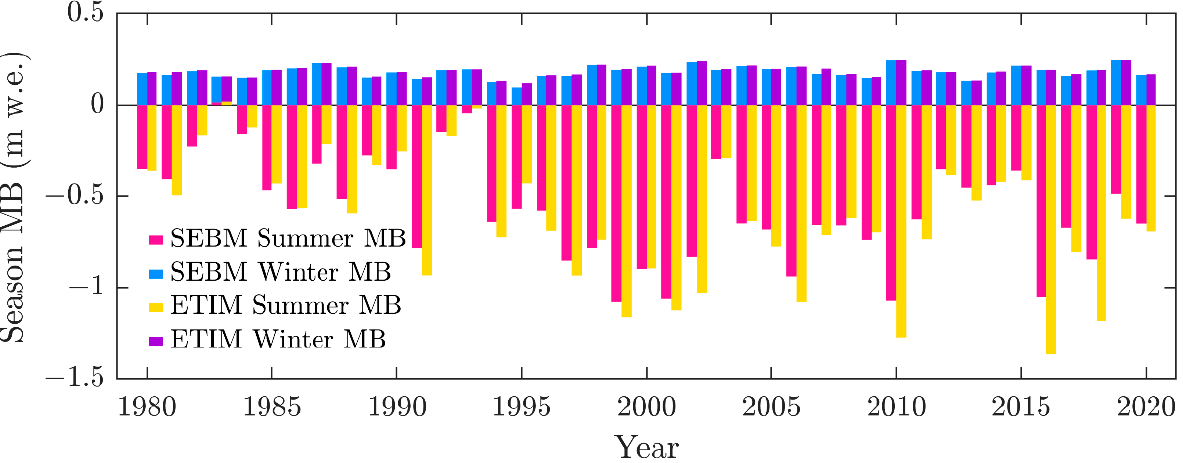
Figure 7. Summer and winter mass balance modeled by SEBM and ETIM.